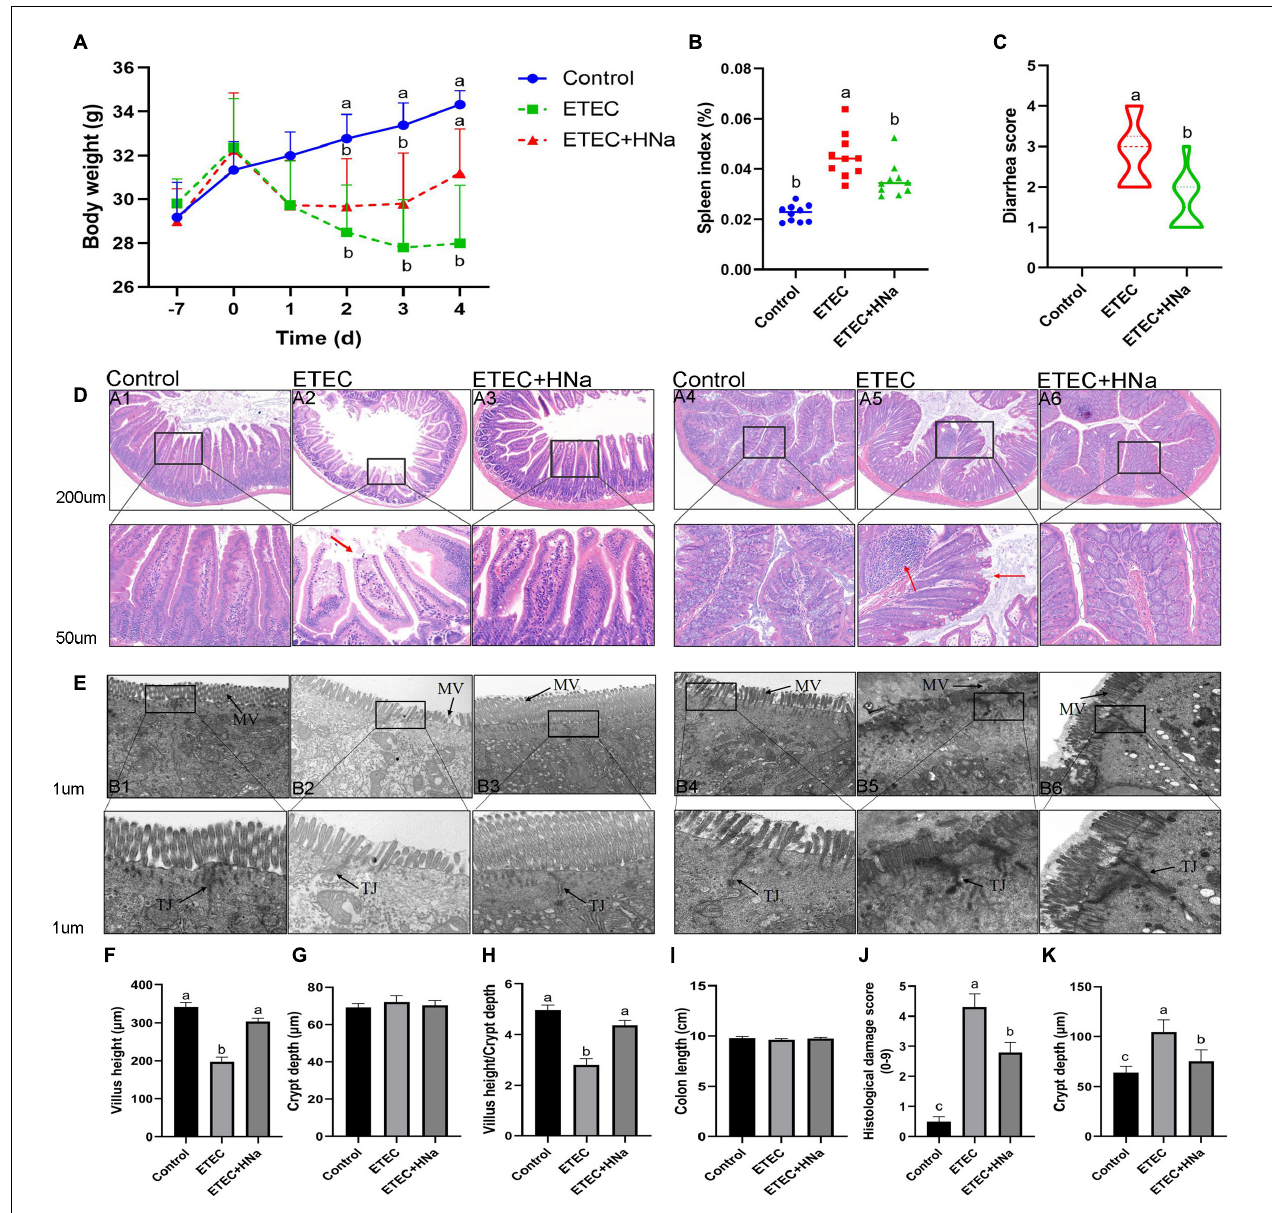
FIGURE 1 | Effects of sodium humate on clinical symptoms, jejunal, and colon pathological morphology of ETEC K88-infected mice. (A) Body weight change, days –7 to 0 were pre-infection, and days 0–4 were post-infection. (B) Spleen index of mice. (C) Diarrhea score. (D) Representative images of the jejunum (A1–A3) and colon (A4–A6) stained with H&E (200 µ m). The red arrow points to the damaged jejunum and colon villus. (E) Jejunum (B1–B3) and colon (B4–B6) morphology shown by transmission electron microscopy (1 µ m). MV, microvilli; TJ, Tight junction. The villus height (F) , crypt depth (G) , and the ratio of villus height and crypt depth of jejunum (H) . The length (I) , histological damage score (J) , and crypt depth (K) of colon. All of the data are expressed as the mean ± SEM. Different superscript lowercase letters within each group indicate significantly different ( P < 0.05).